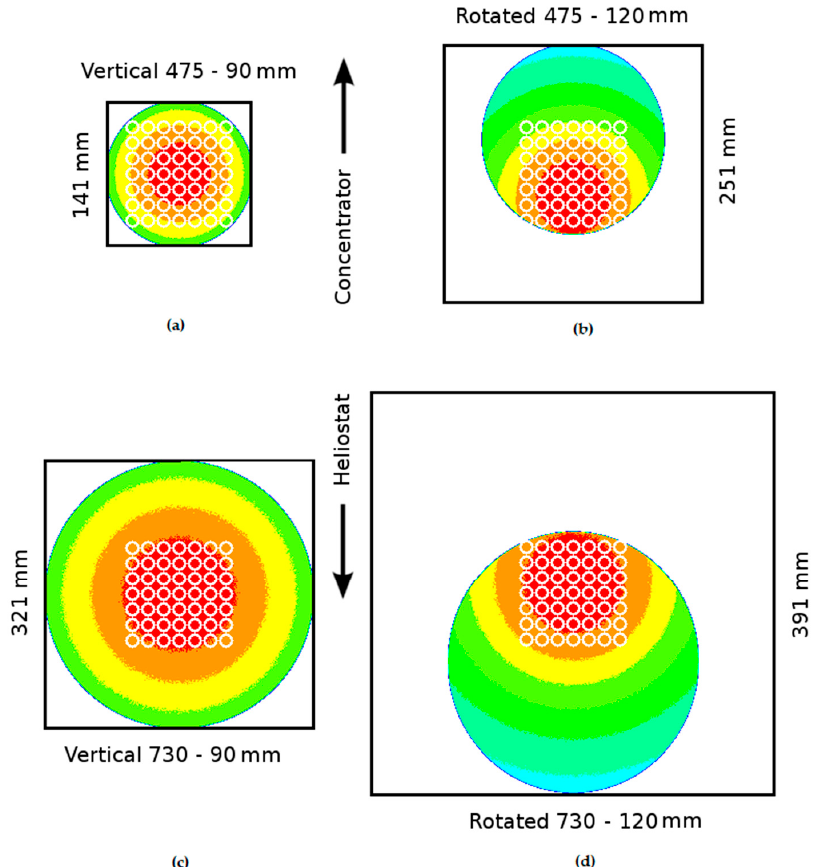
Figure 6. Illuminated regions for vertical ( a , c ) and rotated ( b , d ) beams, for planes 475 ( a , b ) and 730 ( c , d ), showing the 49 circles where data is collected, to compare with the radiometer data. The vertical shift applied to the measurement planes is indicated by the subtracted values: 90 mm for vertical beam, and 120 mm for rotated beam.